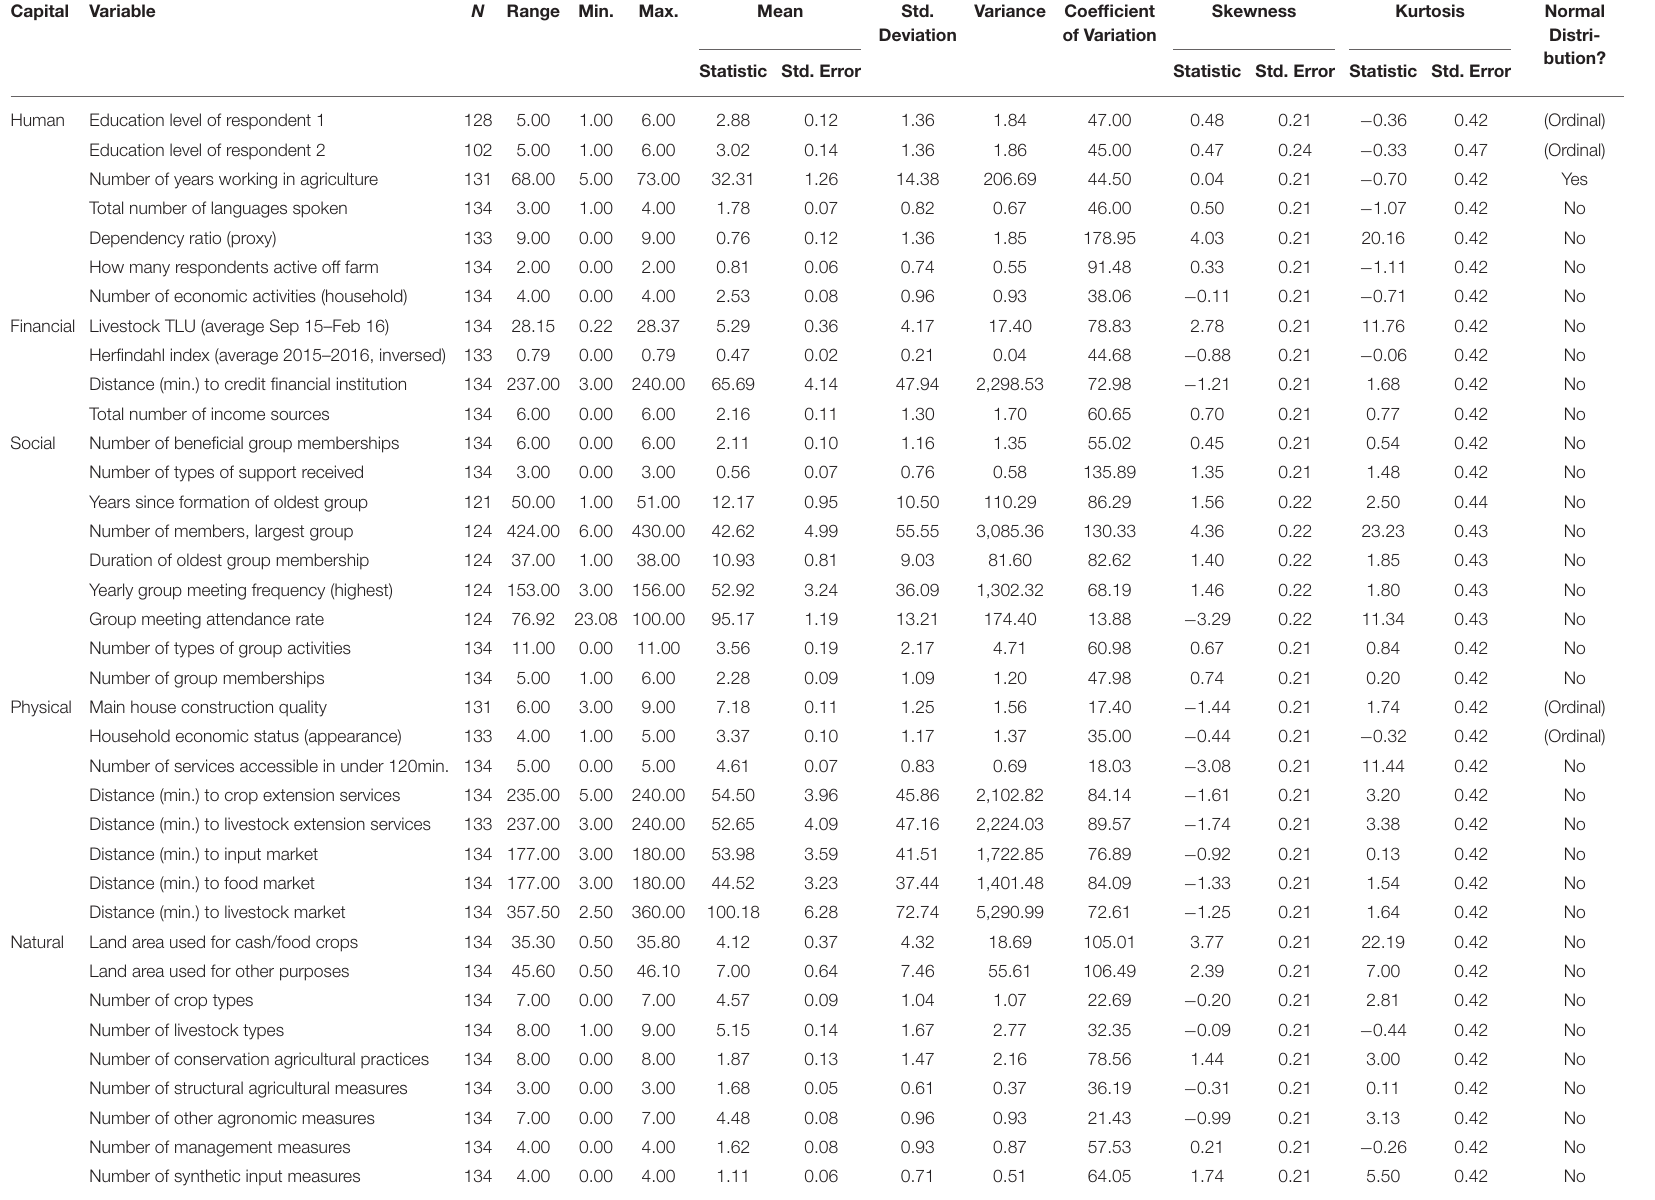
TABLE 1 | Summary of 37 variables and main statistics. Capital Variable N Range Min.